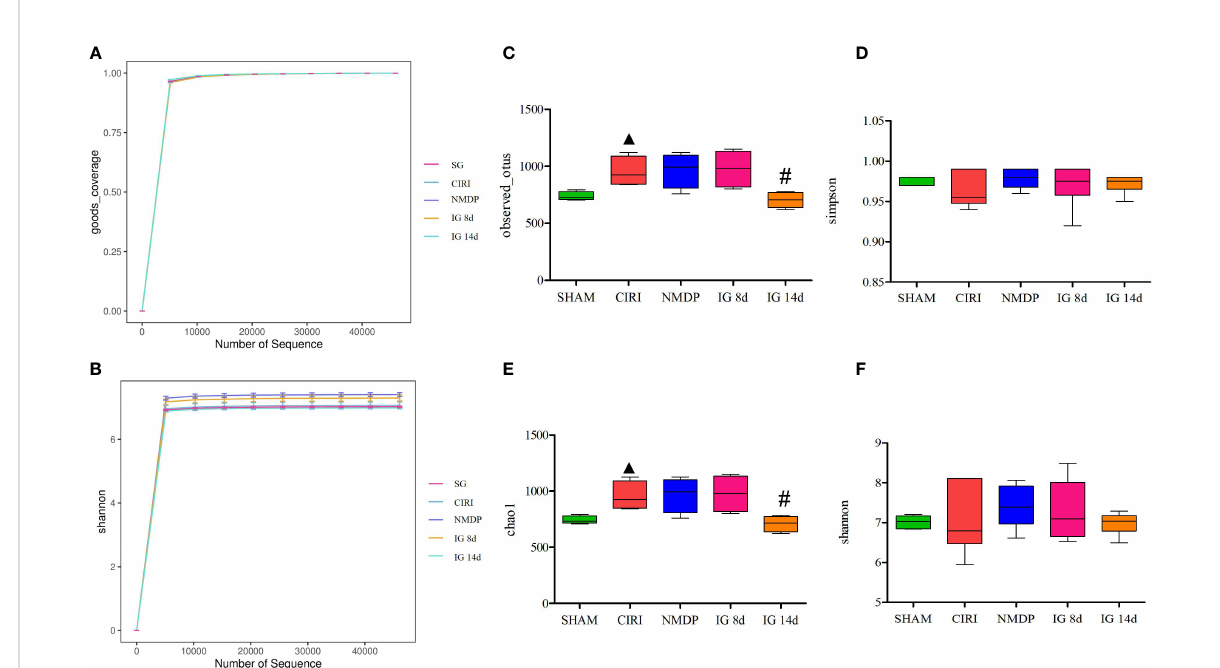
FIGURE 4 Effect of Gastrodia elata Blume on the alpha diversity of the intestinal fl ora. Note: Analysis of the gut microbial diversity was performed on the basis of 16S rDNA sequencing. Good ’ s coverage index (A) and Shannon index (B) are presented. OTUs (C) , Simpson index (D) , Chao1 index (E) , and